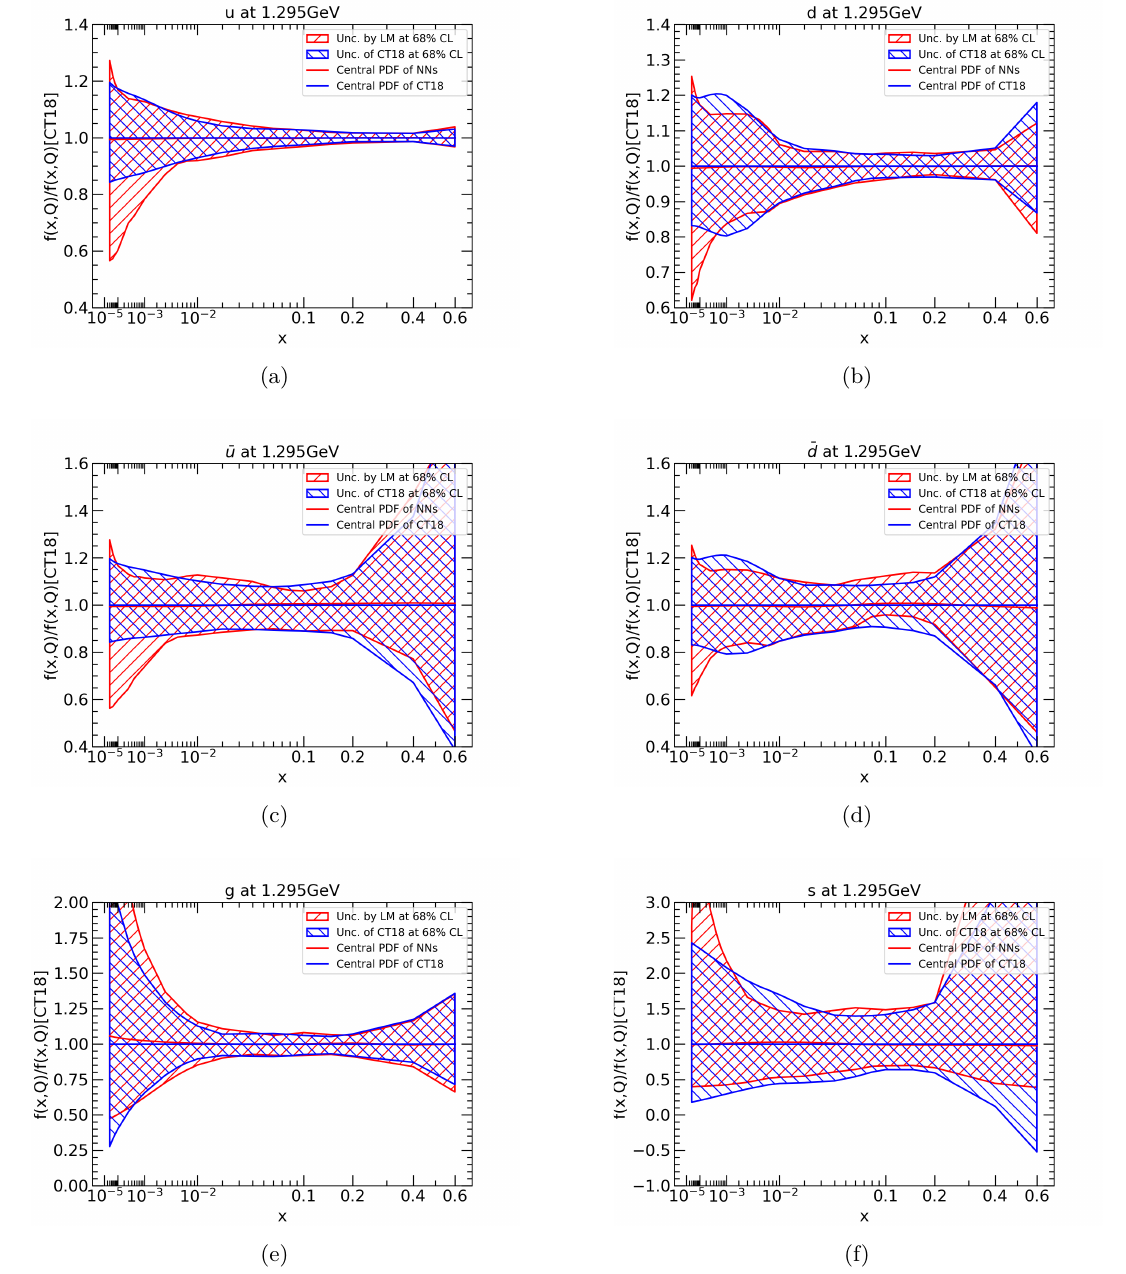
Figure 8 . The parton distribution functions at Q = 1 . 295 GeV for u , d , ¯ u , the red solid lines represent the central values of the CT18 NNLO and the PDFs determined with the aforementioned NNs approximation of χ 2 respectively. The blue and the red hatched areas represent the uncertainties at 68% CL determined with the Hessian method and the LM scans